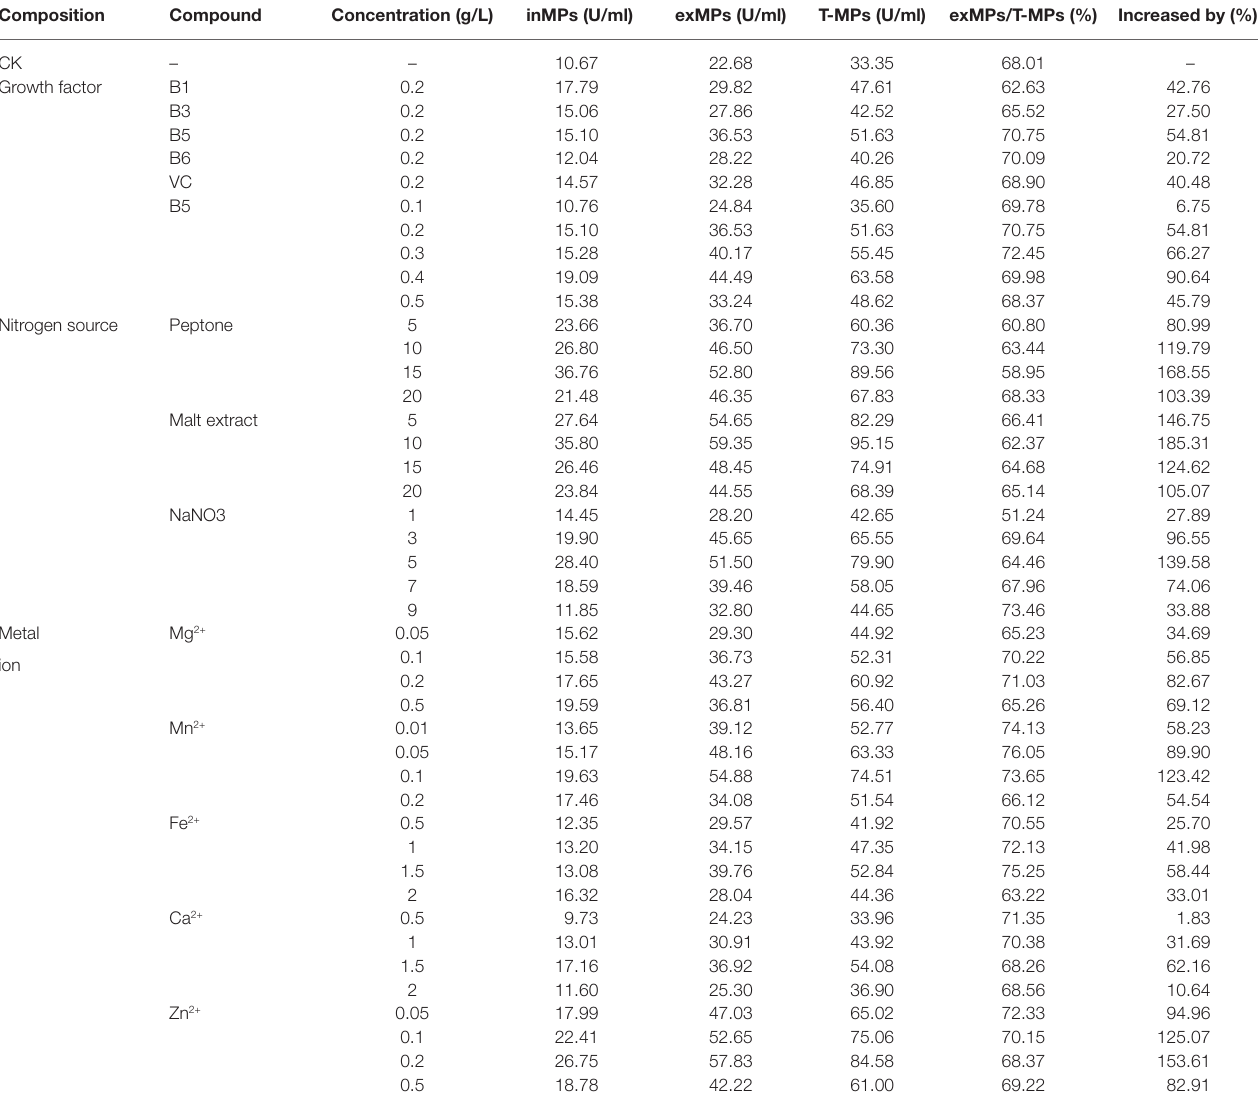
TABLE 1 | The effect of different fermentation medium compounds on the production of yellow Monascus pigments in submerged fermentation for 10 days at 30 ° C and agitated at 150 rpm in the dark. Composition